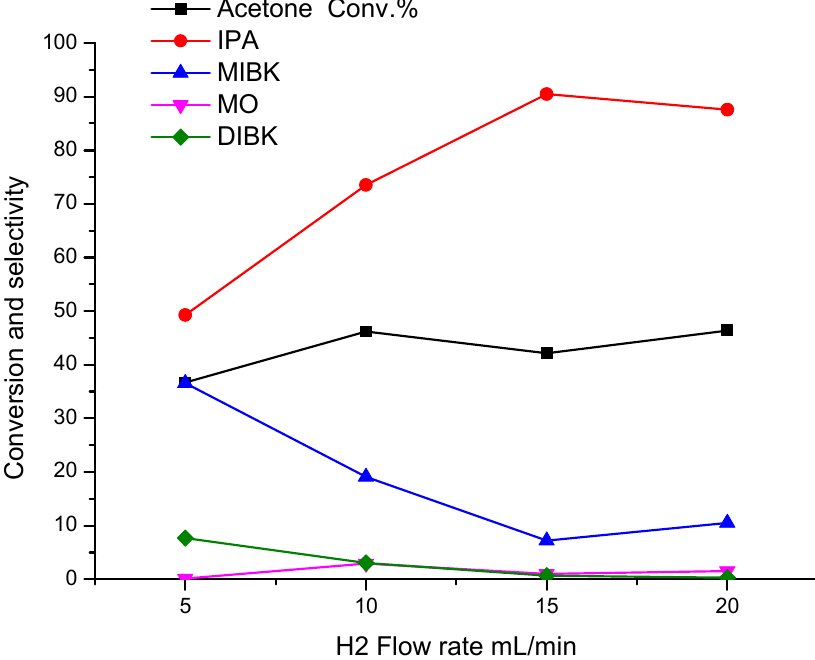
Figure 4. Variations of conversion and selectivity over CAT-IV at reaction conditions: 0.25 g catalyst, t = 250 °C, acetone flow rate = 0.01 mL/min, TOS = one hour.